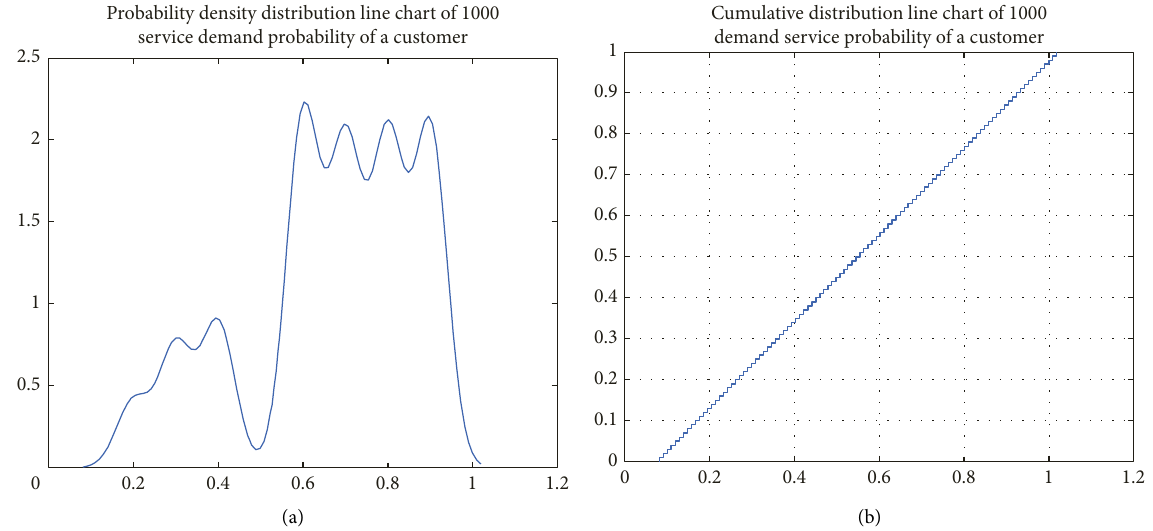
Figure 1: Customer data distribution charts. (a) Probability density distribution line chart and (b) cumulative distribution line